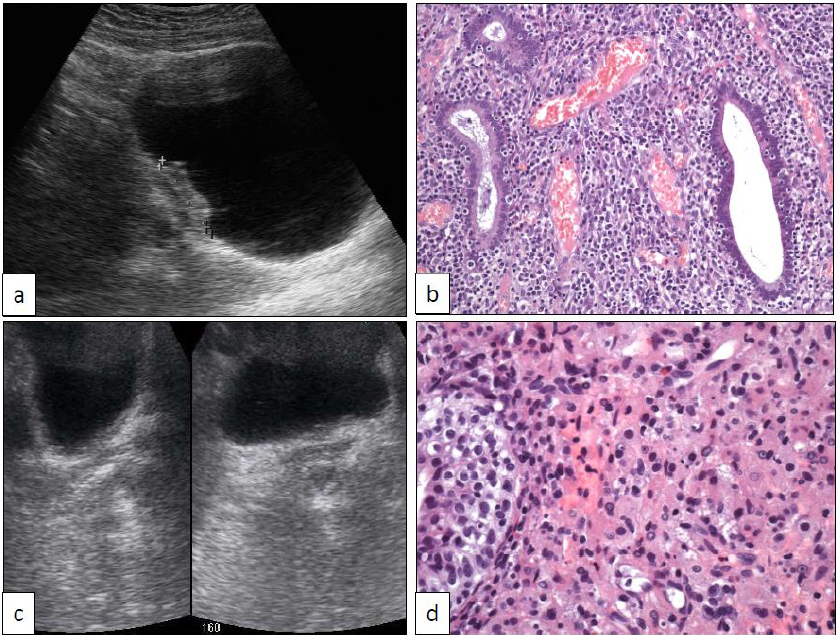
Figure 2. Bladder endometriosis (( a ) sonographic and ( b ) histologic features (250×)) and malakoplakia (( c ) sonographic and ( d ) histologic features